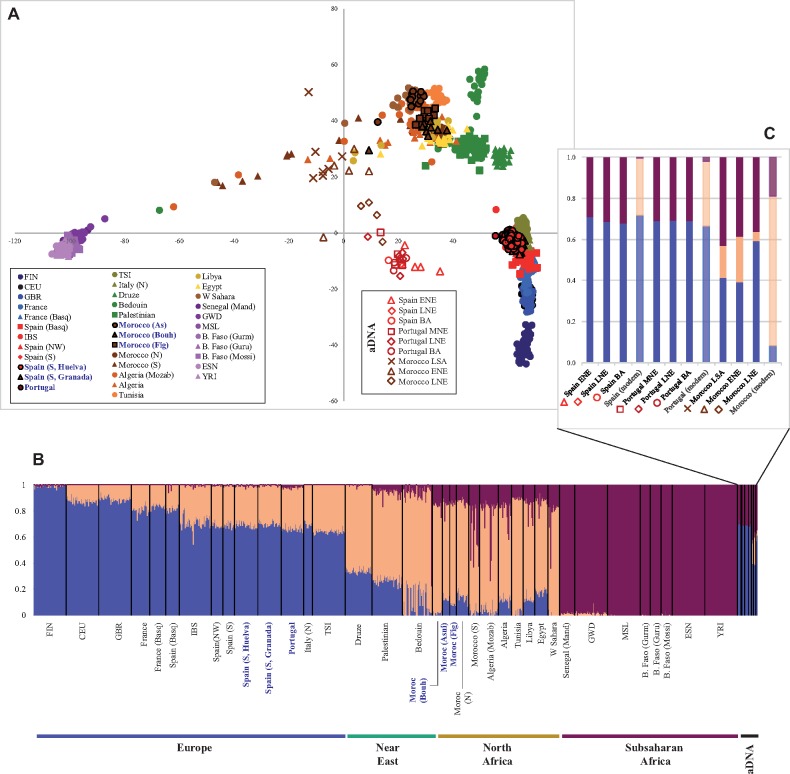
A genomic chronology of the studied area. Ancient DNA samples are integrated with Database 2B. (A) PCA built with ancient and modern samples (see supplementary tables S8 and S10, Supplementary Material online). (B) ADMIXTURE plot (K = 3). (C) Mean global ancestry proportions (K = 3) estimated in Spanish, Portuguese, and Moroccan periods (LSA, Late Stone Age; ENE, Early Neolithic; MNE, Middle Neolithic; LNE, Late Neolithic; BA, Bronze Age). Average values for modern samples (see pale bars) were calculated from Database 2B (supplementary table S8, Supplementary Material online) including the following populations: IBS, SPGA, SPBA, SPAN, SPWA, SPEA (Spain modern), SPOR (Portugal modern), and MAAS, MABO, MAFI, MANO, MASO (Morocco modern).